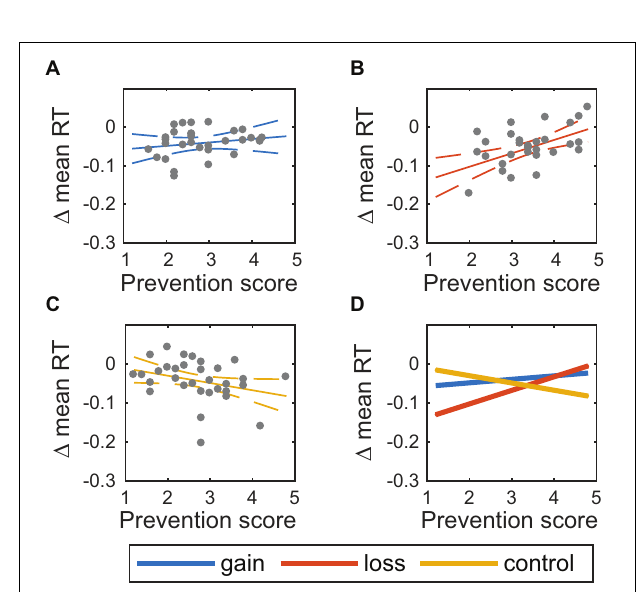
FIGURE 4 | Distributions of accuracy scores for the four kinds of stimuli in the transfer task. Error bars show a bootstrapped 95% CI for the mean computed on logit-transformed accuracy. Colors indicate the training condition, with match indicating those participants who were assigned to the condition that aligned with their predominant chronic regulatory focus ( n = 37), mismatch indicating those assigned to the condition that misaligned with their predominant chronic regulatory focus ( n = 24), and the control condition which involved no points ( n = 31).